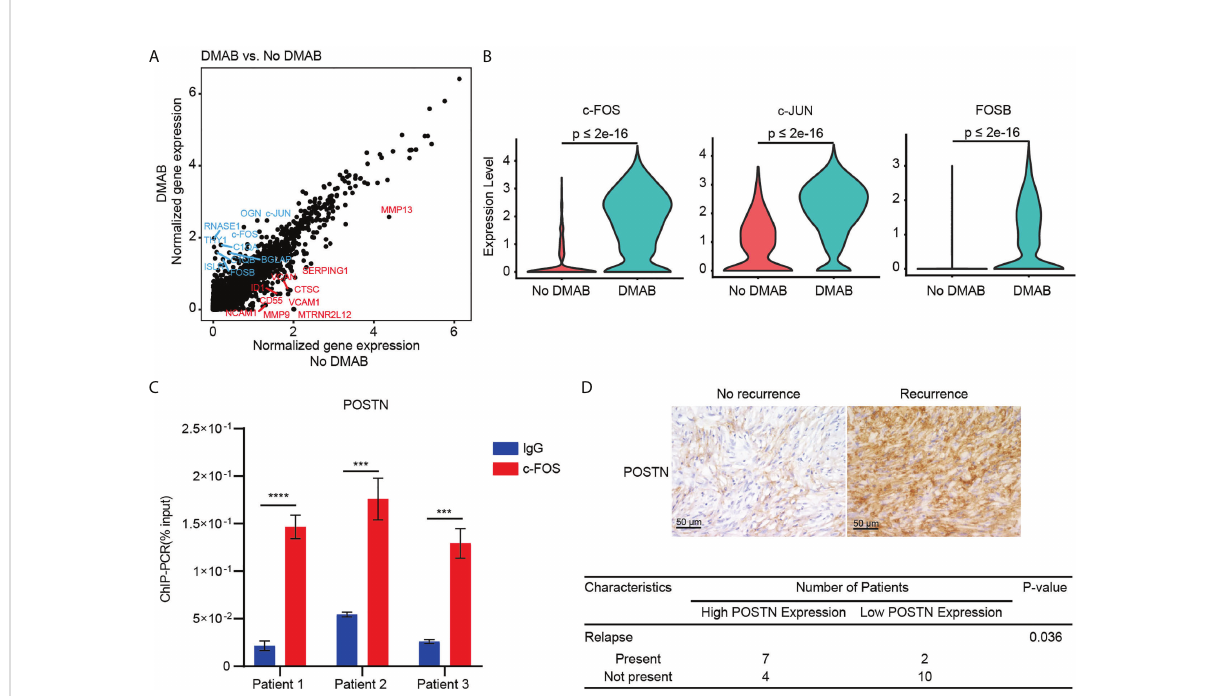
FIGURE 5 C-FOS-mediated POSTN expression is associated with the relapse of GCTB after DMAB treatment. (A) Scatter plot showing the DEGs of tumor cells from DMAB-treated sample versus No DMAB sample. The top 10 DEGs were labeled in blue (upregulated in DMAB-treated samples) or in red (upregulated in No DMAB samples). (B) Violin plot showing the expression levels of activator protein 1 (AP-1) transcription factor (c-FOS, c- JUN, and FOSB) in tumor cells from the No DMAB (red) and DMAB-treated (blue) samples. The p values were calculated using a Student ’ s t test. (C) ChIP-qPCR analysis of c-FOS enrichment at the POSTN promoter region in 3 GCTB tissues. Signi fi cance was determined by a Student ’ s t test. (D) Representative IHC images of POSTN in GCTB without recurrence (n = 14) versus GCTB with recurrence (n = 9) after DMAB treatment. Scale bar, 50 m m. Statistical table of 23 patients with GCTB by POSTN staining intensity. Signi fi cance was determined by a fi sher exact test. * P < 0.05; ** P < 0.01; *** P < 0.001 and **** P < 0.0001. All the results were obtained from three independent experiments. Values are presented as mean ±